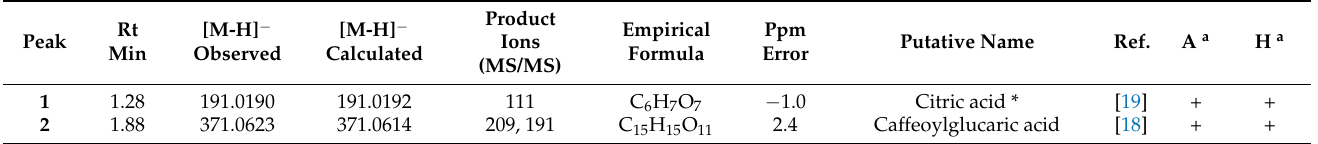
Table 1. Chemical profile of the aqueous and hydroethanolic extracts obtained from the leaves of Gossypium hirsutum